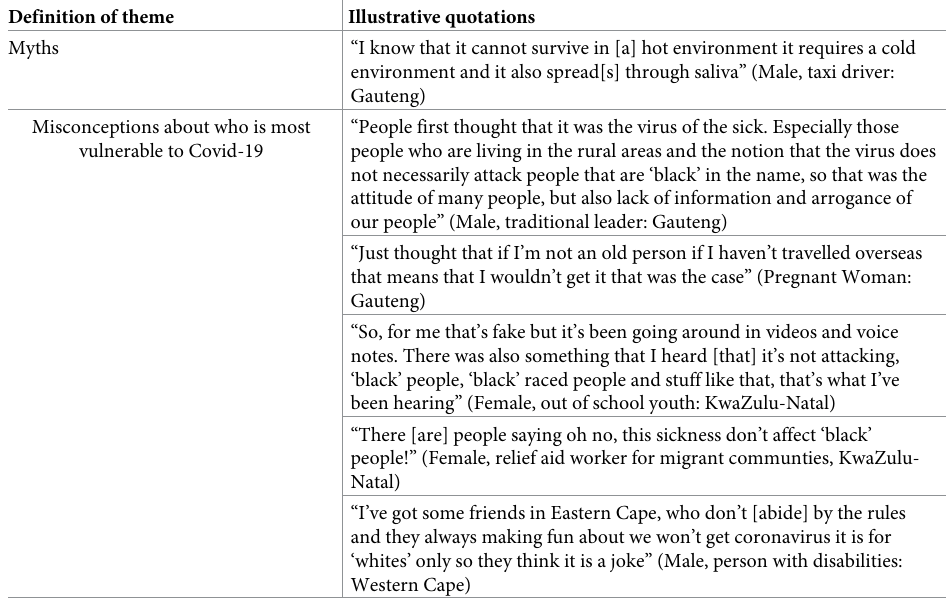
Table 4. Myths and misconceptions about who is most vulnerable to